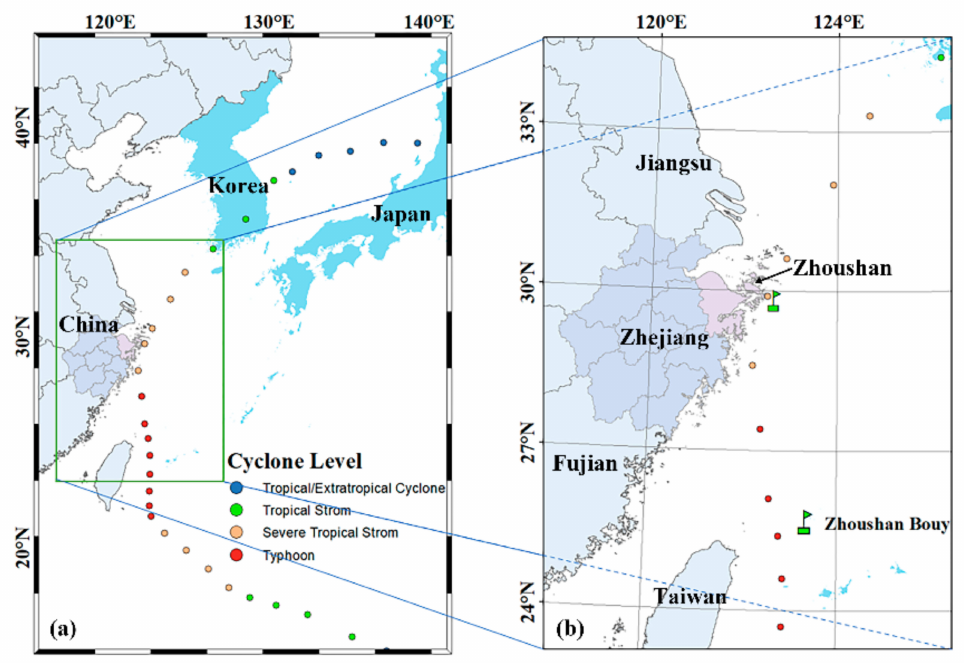
Figure 2. Study area ( a ) Northwest Pacific Ocean ( b ) East China